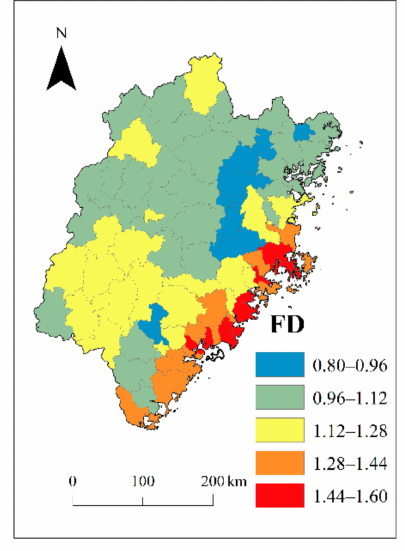
Figure 4. Fractal dimensions (FD) of Fujian Province in 2012.